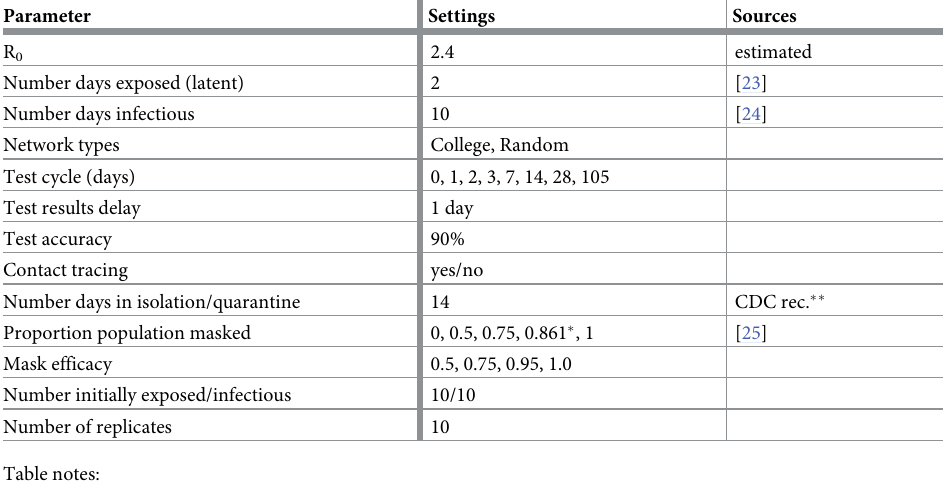
Table 1. Parameter settings for simulations. These are the basic settings used in the simulations. This resulted in 6400 simulations.